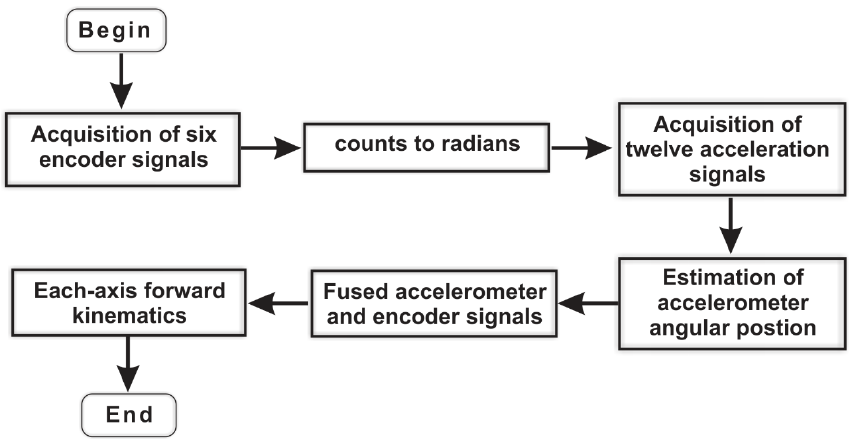
Figure 2. Flow diagram to estimate forward